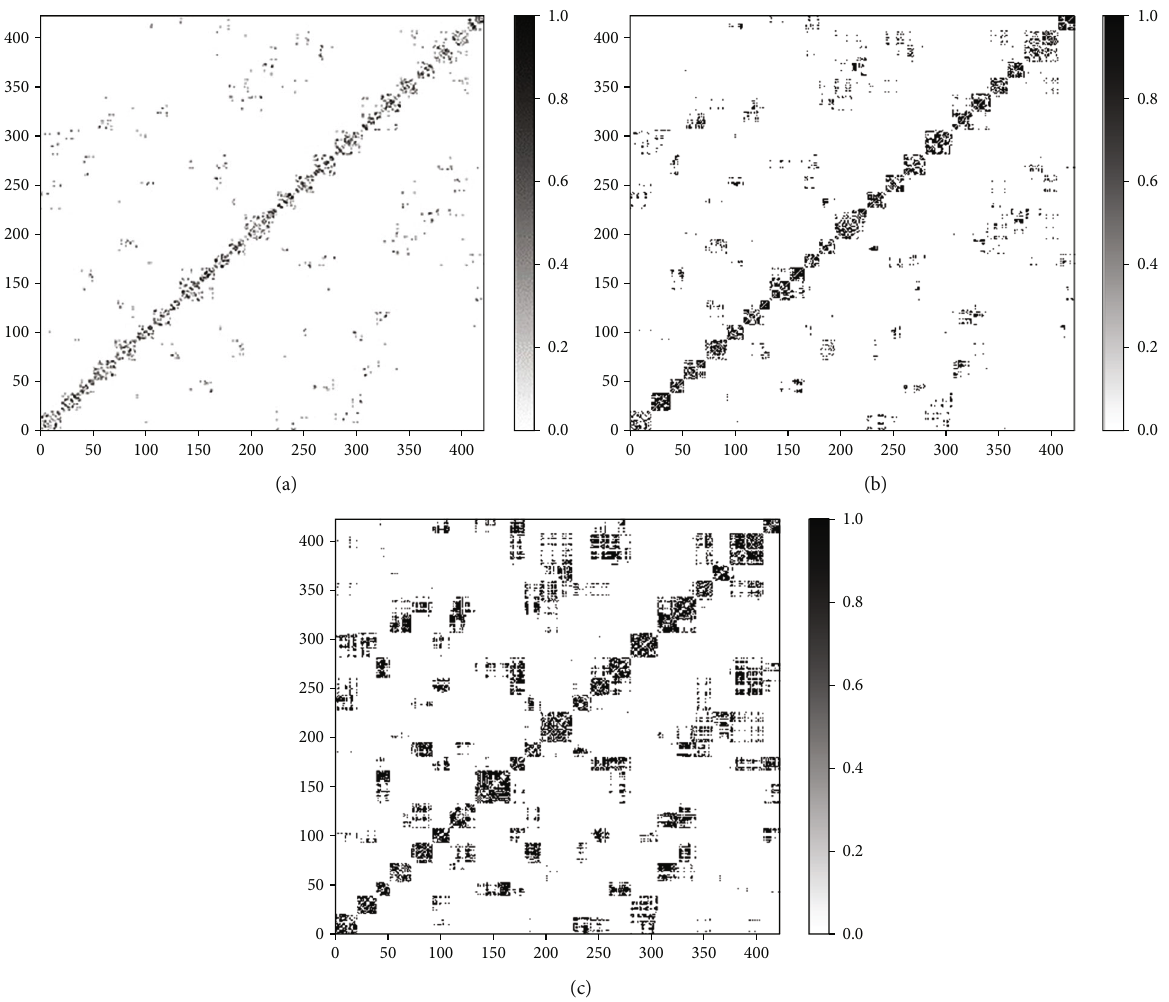
Figure 3: Adjacency matrices for neighborhood, transportation, and functional similarity. (a) Neighborhood adjacency. (b) Transportation adjacency. (c) Functional-similarity